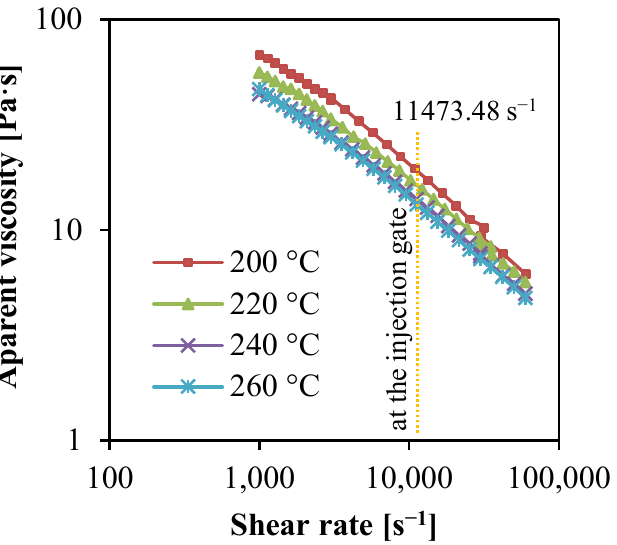
Figure 3. Apparent viscosity of PP matrix changing with the shear rate at different temperatures.